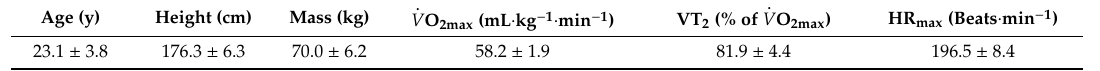
Table 1. General characteristics of participants (mean ± SD) ( n = 10).